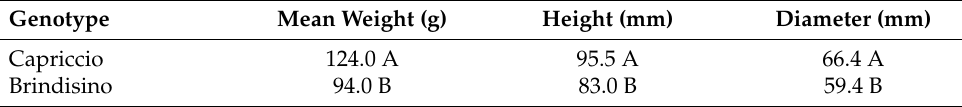
Table 7. Effects of genotypes on weight and size of buds 1